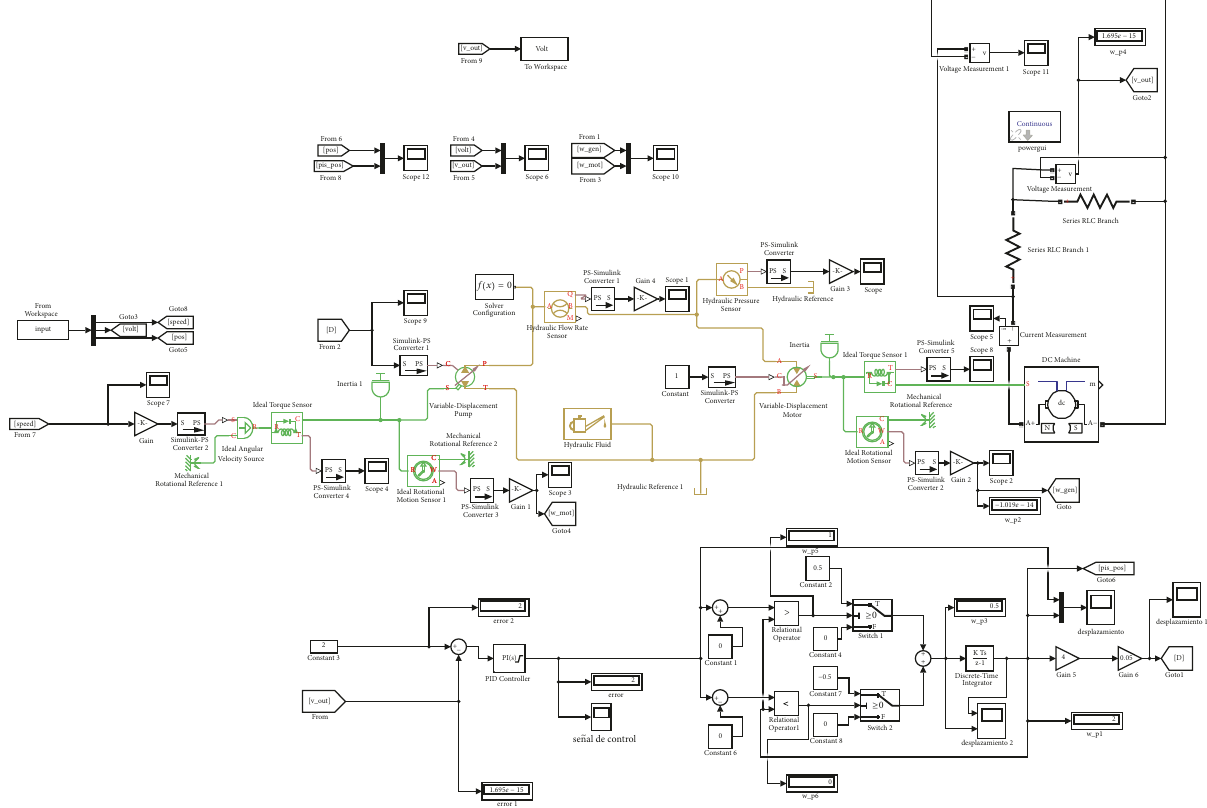
Figure 12: Computational model of the hydraulic wind power drive train.